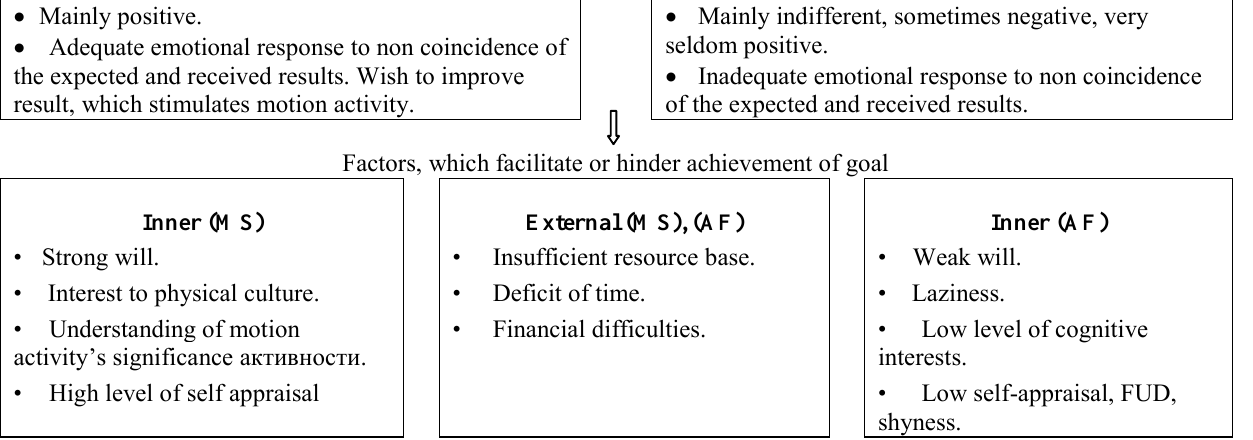
Fig.1. Schema of purposeful motion activity of students with motivation for success and students, avoiding